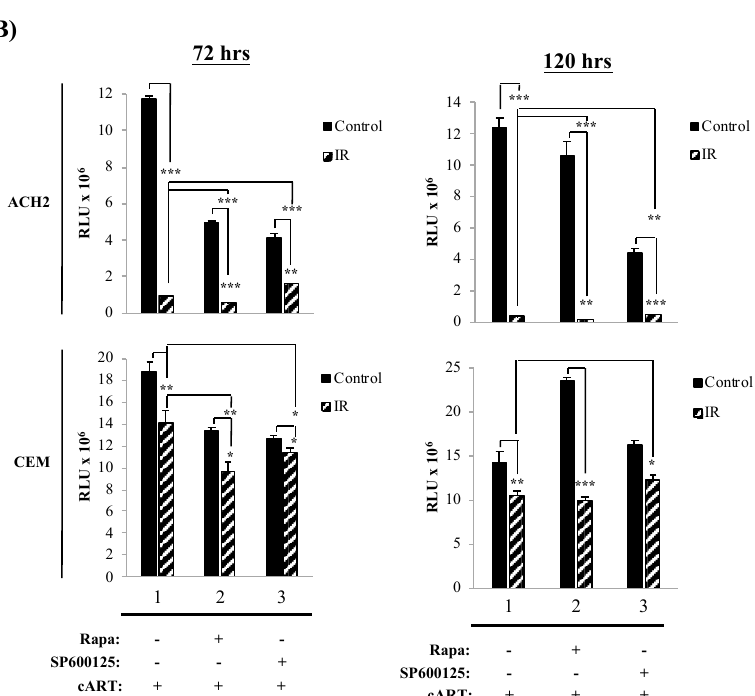
Figure 3. A combination of IR, AI, and serum starvation induces cell death of HIV-1-infected cells. Cell viability was assessed at two-time points (72 h and 120 h). All cells were pretreated for 3 days with cART (10 µ M cocktail). Additionally, cells were treated with IR - /+ (10 Gy), 0.1% DMSO (control), Rapa (300 nM; AI via mTOR inhibition) or SP600125 (300 nM; JNK pathway inhibitor). ( A ) Time titration for U1 and ( B ) ACH2 cells.